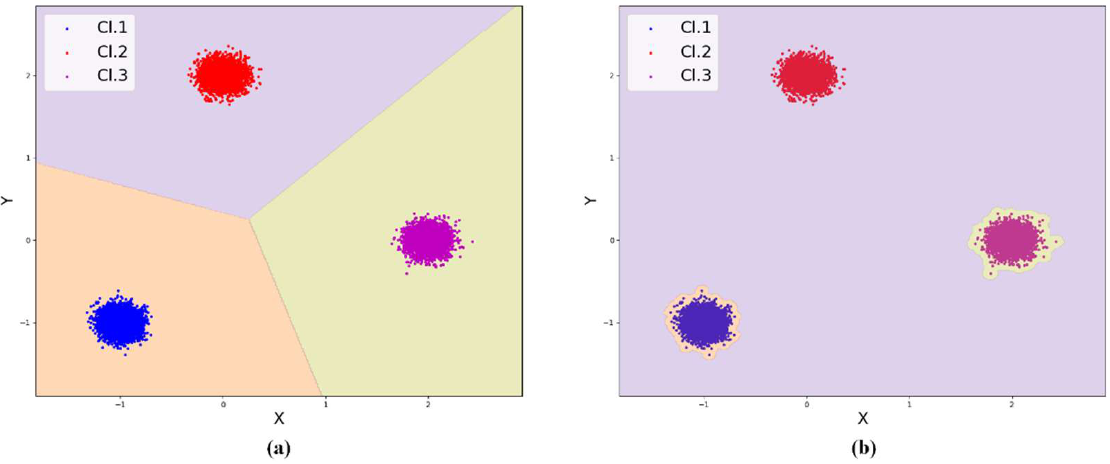
Figure 5. The first ( a ) and second ( b ) feature space separation variant of machine learning classifiers.